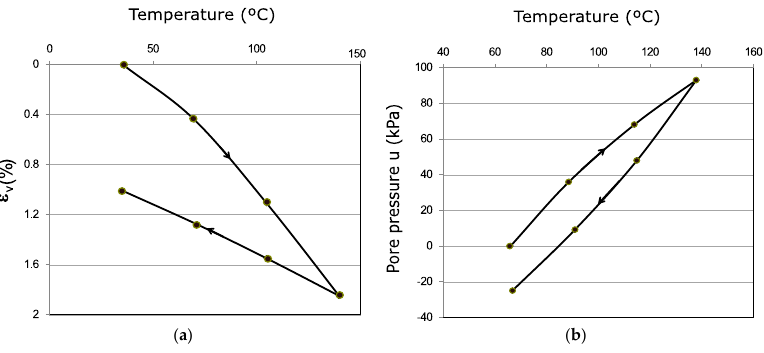
Figure 22. Volumetric strain ( a ) and pore pressure change ( b ) in undrained conditions for saturated illite under a constant total stress of 200 kPa as a function of temperature (adapted from Reference [200]).